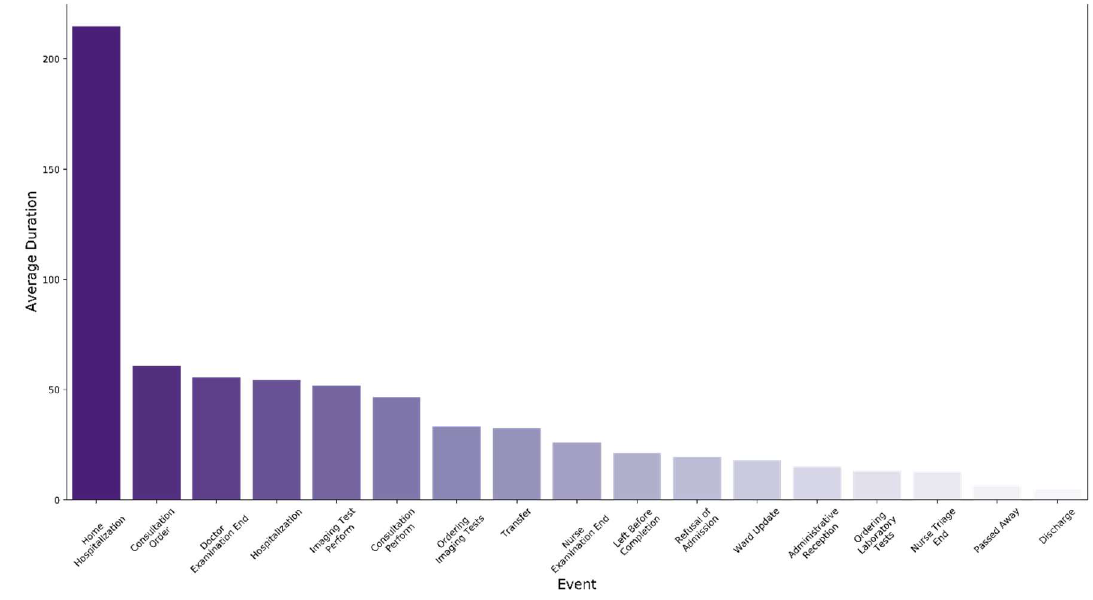
Figure 5. Average duration for each event type.